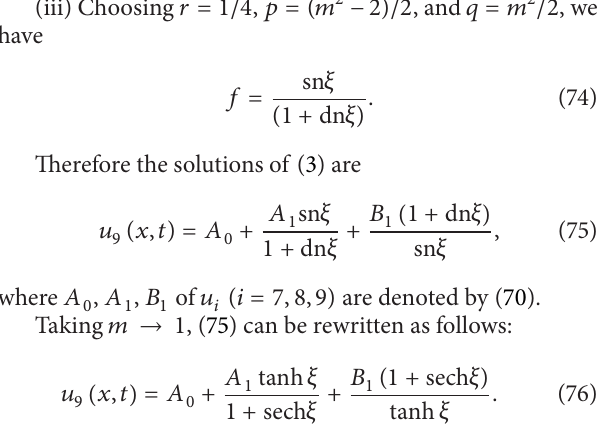
Figure7:Thesolitarywaveandbehaviorofthesolutions ℎ(𝑥,𝑦,𝑡) = 7 + 4 tanh 2 (𝑥 − 2𝑦 + 𝑡) + 4 tanh −2 (𝑥 − 2𝑦 + 𝑡) for 𝑡 = 0 , −4 ⩽ 𝑥 ⩽ 4 , and −4 ⩽ 𝑦 ⩽ 4 .